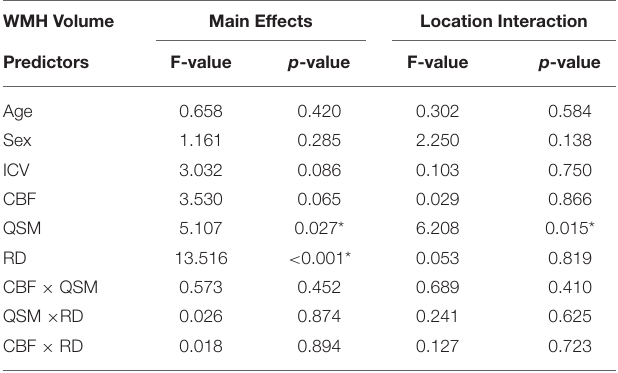
TABLE 3 | Total explained variance (Adjusted R 2 ) and explained variance attributed to the newest added predictor (Adjusted R 2 change) at each step of the linear regression predicting composite WMH volume.